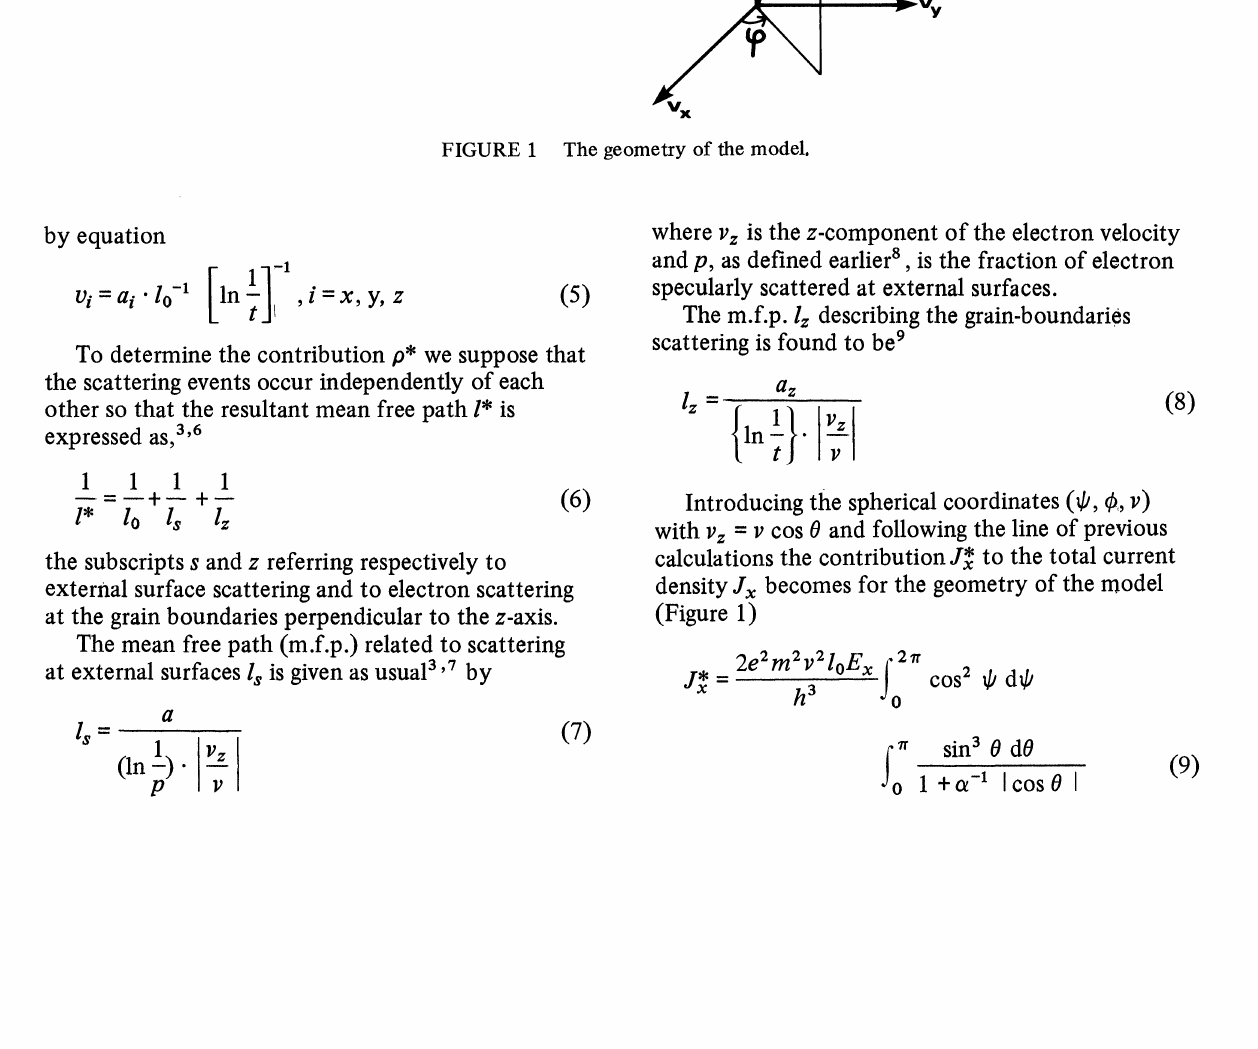
FIGURE The geometry of the